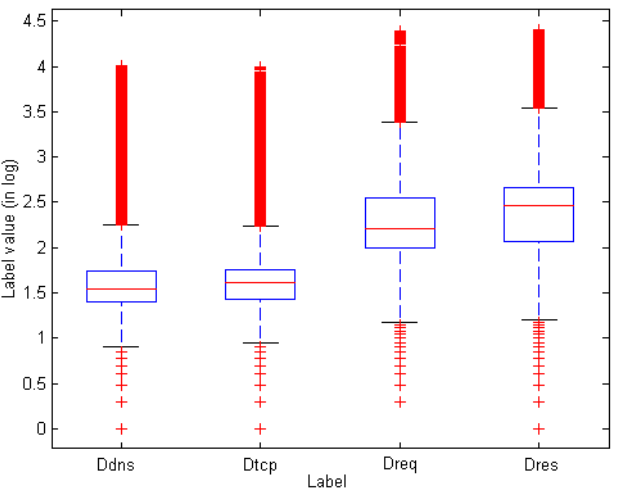
Figure 1. Boxplot of key quality indicators (KQI) labels (unit: ms).